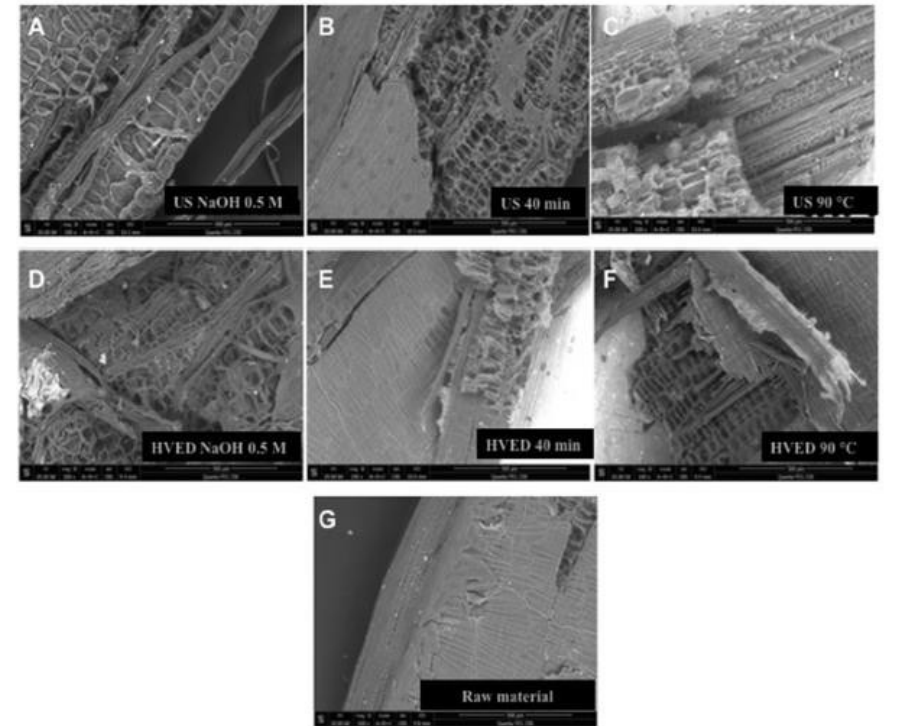
Figure 4. SEM images of pretreated RapS pulps samples: UAT (T = 80 ◦ C, time = 20 min, NaOH = 0.5 M) ( A ); UAT (T = 60 ◦ C, time = 40 min, NaOH = 0 M) ( B ); UAT (T = 90 ◦ C, time = 20 min, NaOH = 0 M) ( C ); HVED (T = 80 ◦ C, time = 20 min, NaOH = 0.5 M) ( D ); HVED (T = 60 ◦ C, time = 40 min, NaOH = 0 M) ( E ); HVED (T = 90 ◦ C, time = 20 min, NaOH = 0 M) (F ) and raw material ( G ) (magnification 100). Reprinted from Biomass and Bioenergy , 95, 92–98, Copyright (2016), with permission from Elsevier.